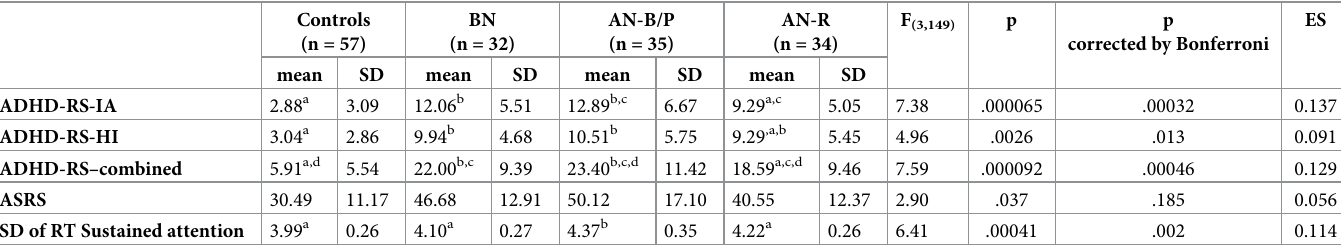
Table 6. Assessment of attention functioning: Four-group analysis